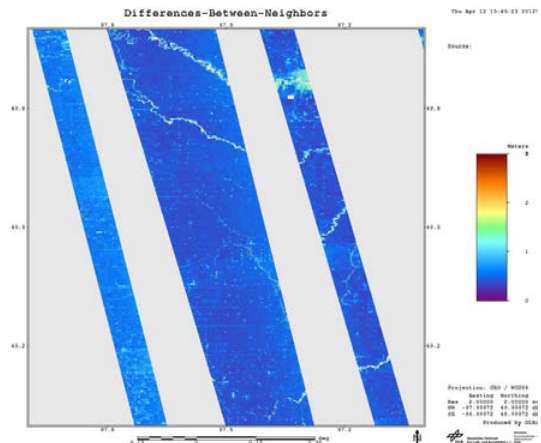
Figure 5: Difference between neighboring acquisitions, tile N49W98, range of values [0; 3]